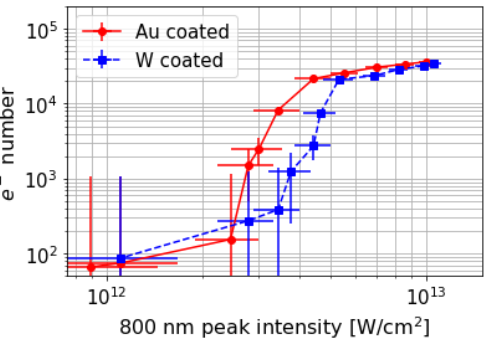
Figure 7. Electron emission from tungsten coated blades from multiple trials as measured by retarding field spectrometer for both tungsten and gold coated blades.